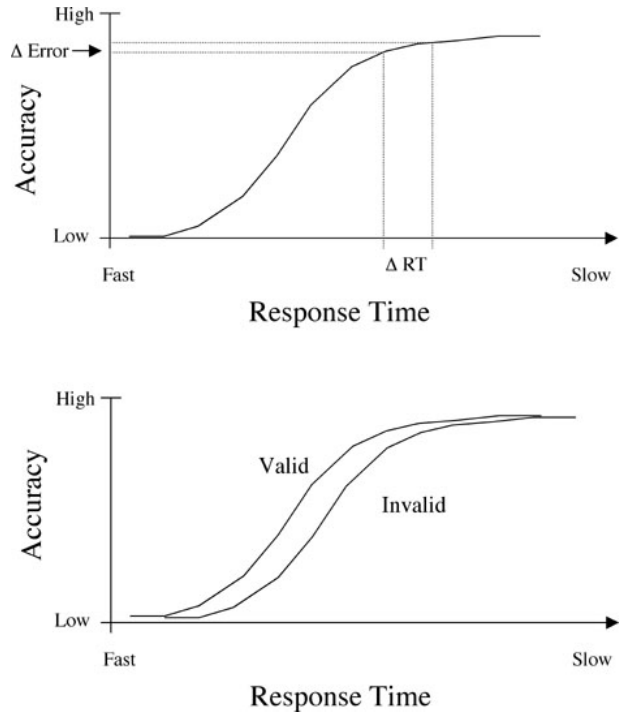
FIGURE 1. (Above) The SAOC[38]. At an accuracy level obtained through normal instruction, a small change in the error rate ( ∆ error) can result in a large change in response time ( ∆ RT). (Below) The enhanced perceptibility hypothesis predicts two different SAOCs: one for “valid” and one for “invalid”